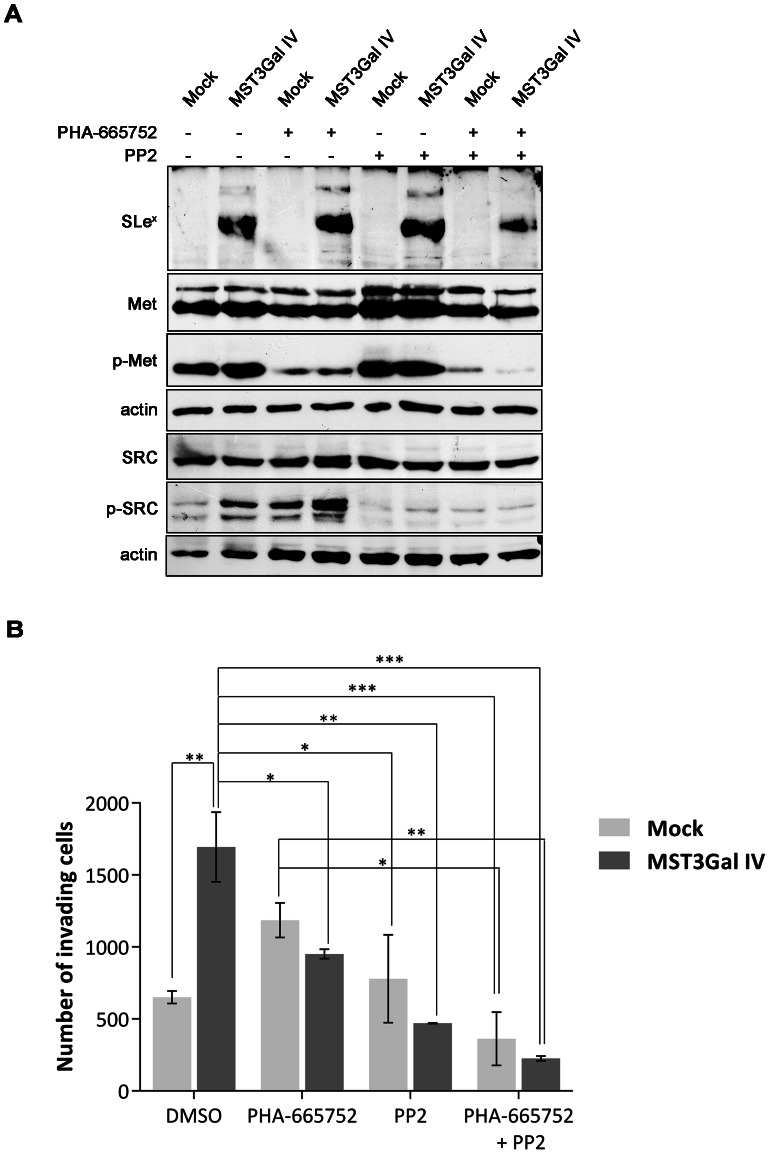
Inhibition of invasion in SLex expressing cells by targeting c-Met and Src activation.
A - Evaluation by WB of the activation of c-Met and Src in the MST3Gal IV and Mock cells with or without the presence of inhibitors of c-Met (PHA-665752) and Src (PP2). B - Cell invasion assay on Matrigel chambers after inhibition of c-Met and Src activation. Cells were seeded on Matrigel-coated filters after incubation with inhibitors for 10 hours. Invading capacity was measured by counting the number of cells that invade, through the Matrigel-coated filter, after 6 hours. MST3Gal IV cells demonstrated an invasive phenotype presenting a significant increased number of invasive cells when compared with MOCK cells. Inhibition of c-Met, Src, and both in combination led to abolishment of cell invasion capability of the MST3Gal IV cells (*p<0.05; **p<0.01; ***p < 0.001).